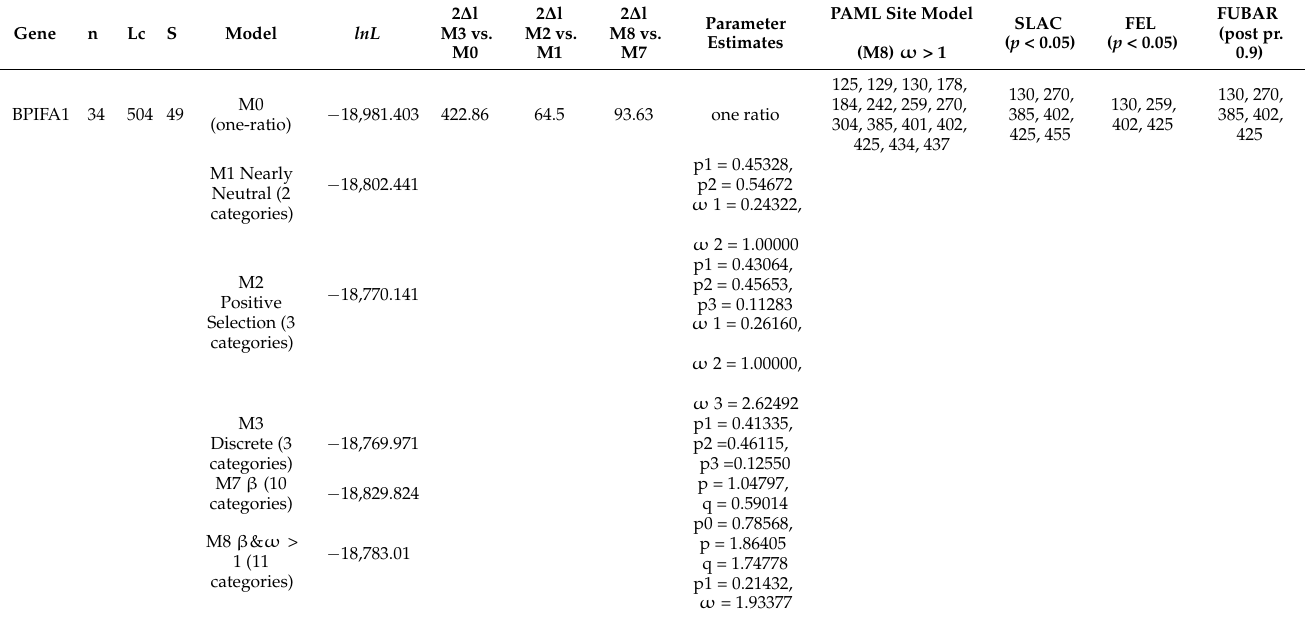
Table 1. Log-likelihood tests and statistics for positive selection among codons in CODONML in PAML using the codon frequency model: F3x4.